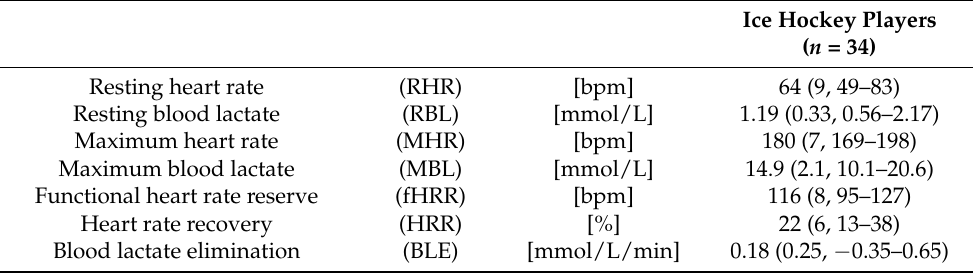
Table 2. Heart rate and metabolic responses with the abbreviations used and associated measurement units of the study participants. Values presented as mean (one standard deviation, minimum and maximum).